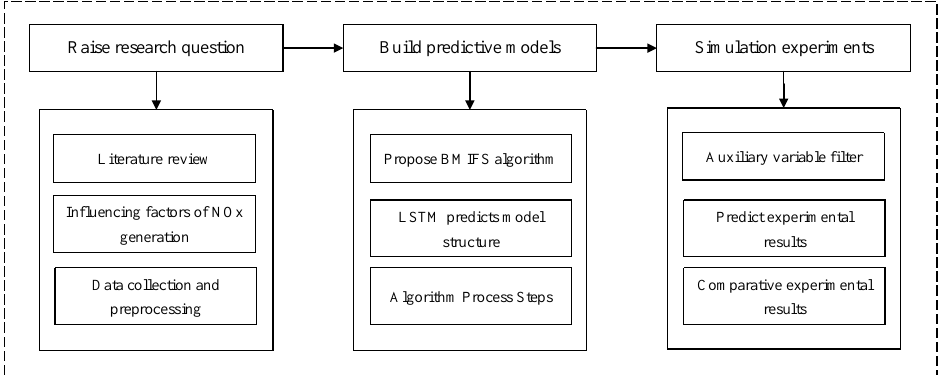
Figure 1. Overall research process flow chart.